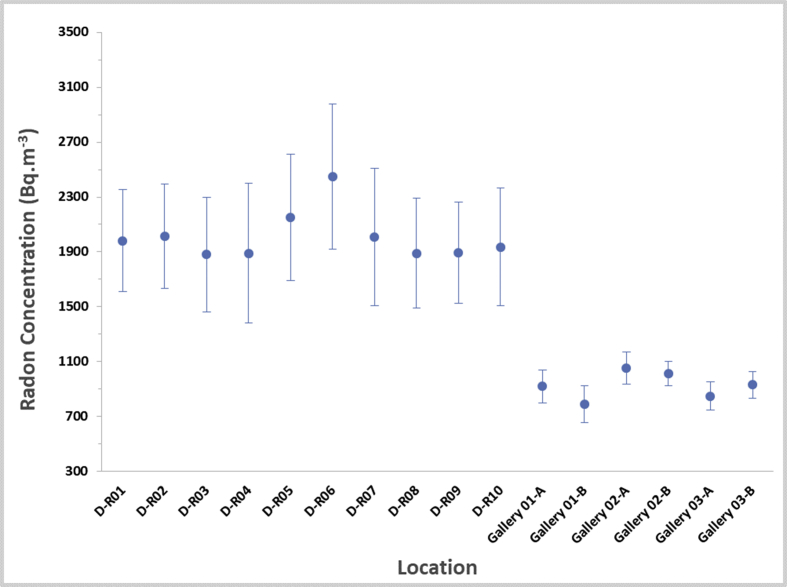
Activity concentrations of 222Rn in thermal baths.